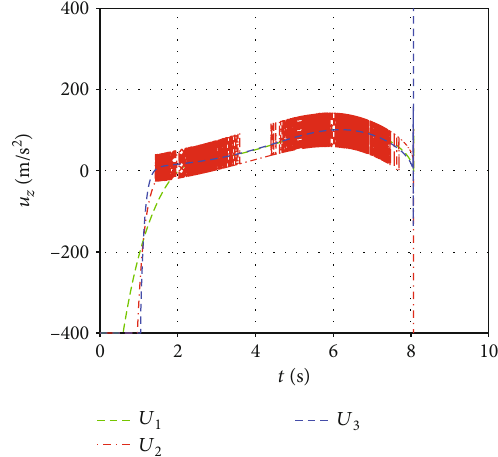
Figure 28: Acceleration instruction u